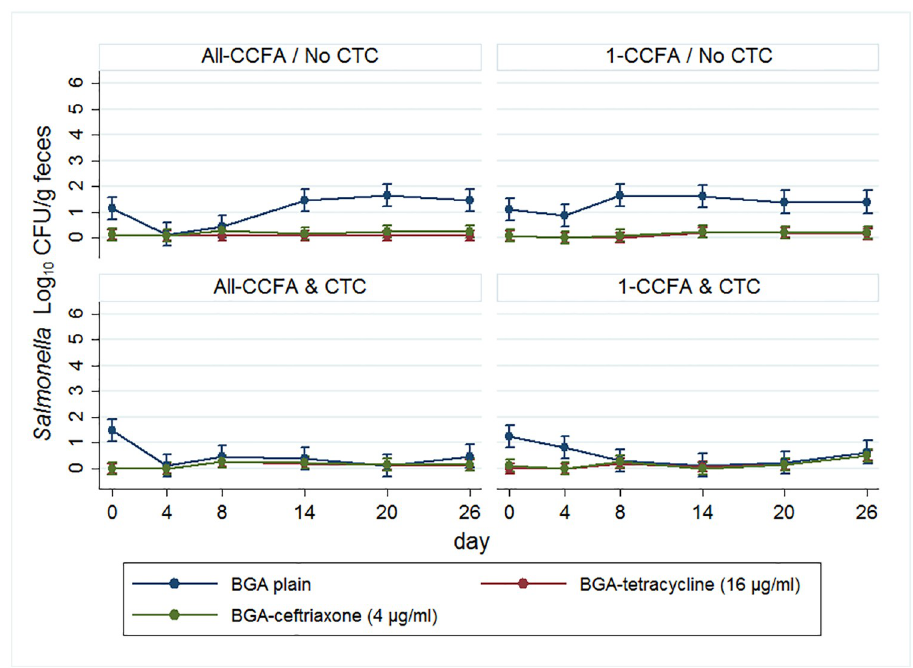
Fig 2. Quantity of Salmonella modeled using multilevel mixed linear regression. Blue: colony growth on plain BGA, red: colony growth on BGA-tetracycline, green: colony growth on BGA-ceftriaxone.